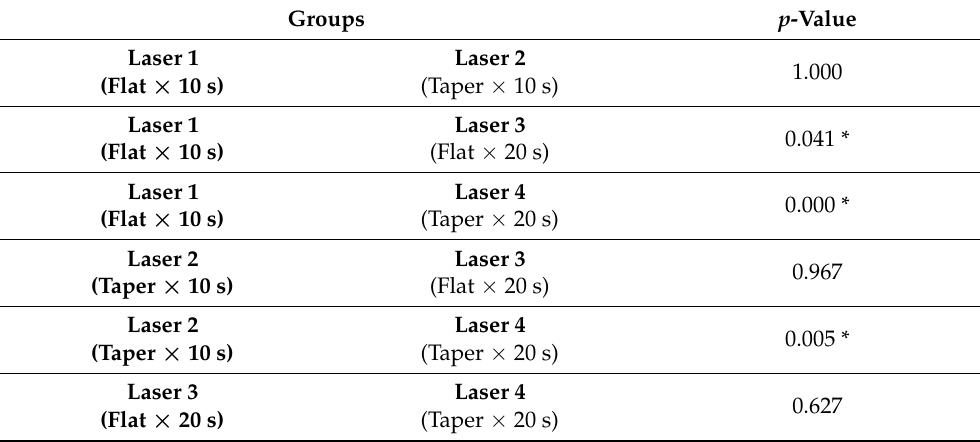
Table 3. Bonferroni method for multiple comparisons of all groups—count of debris, (*) significant result.